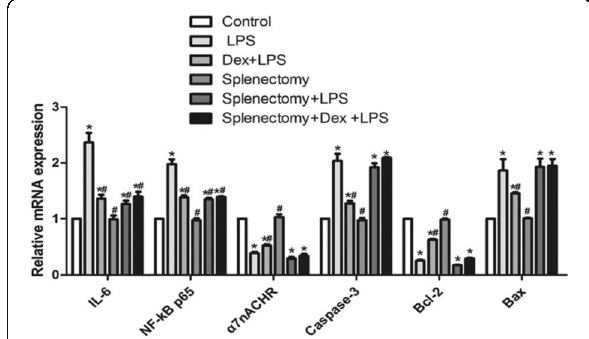
Fig. 5 (abstract 000504). The contents of Cr and Cys-C in different groups